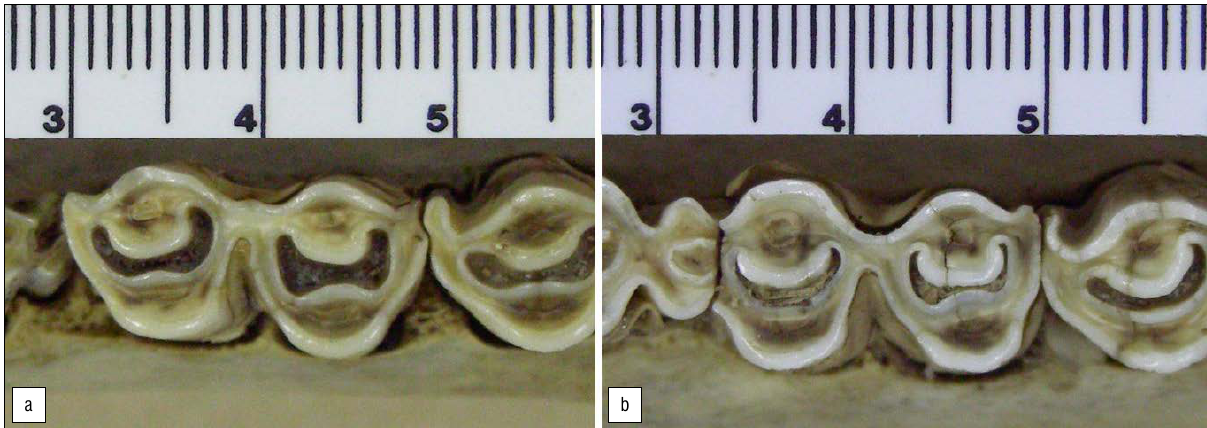
(a) Lower first molar (M